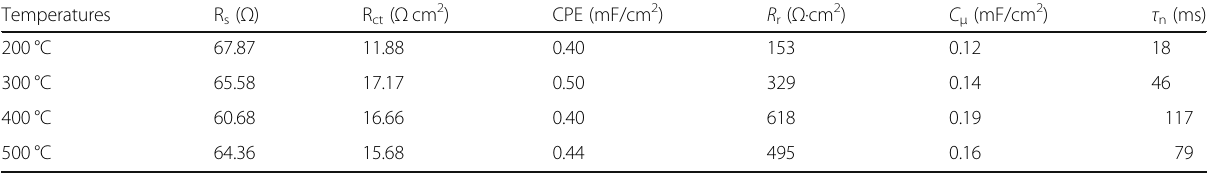
Table 3 Fitted values of resistance, capacitance, and electron lifetime in EIS spectra at − 0.4 V bias